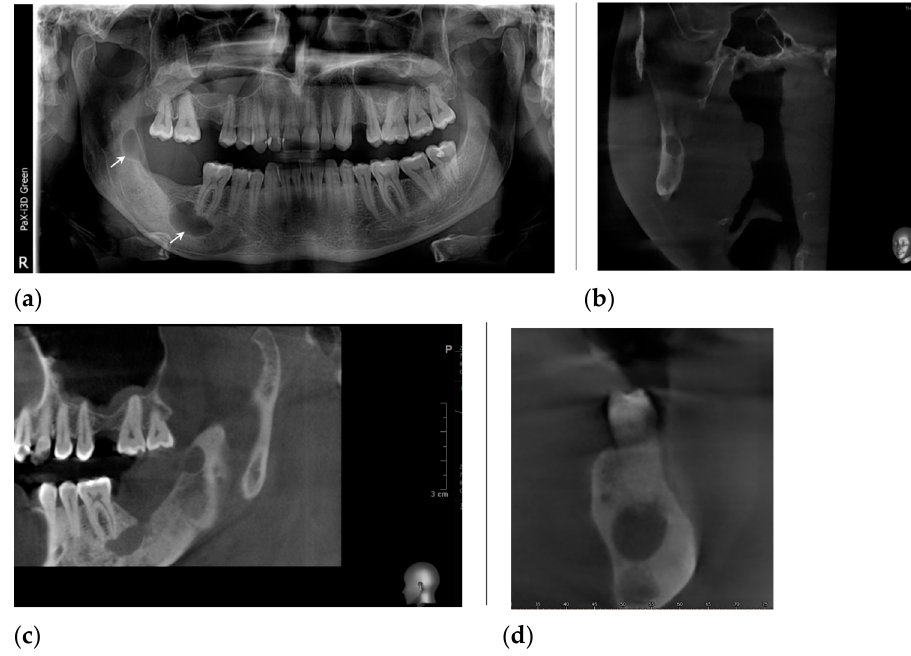
Figure 8. The radiological aspects: ( a ) panoramic radiograph demonstrate two well-defined osteolytic